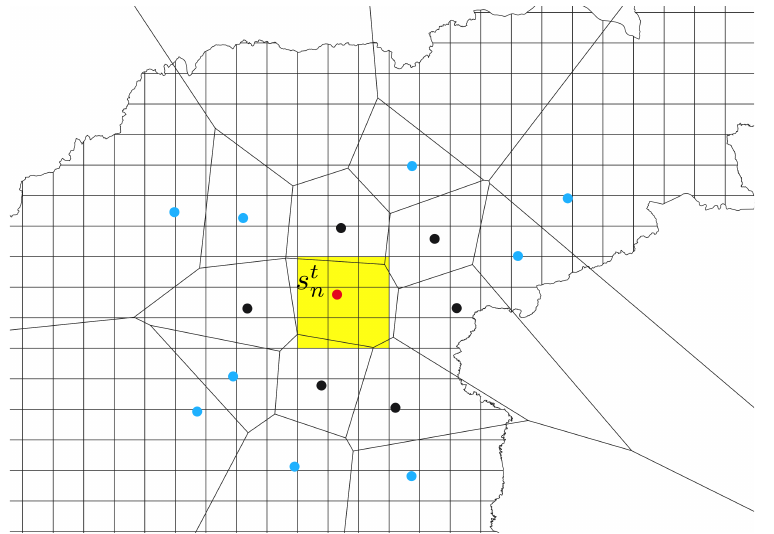
Figure 2. Voronoi diagram constructed on the sensors, where sensor s t n is marked by the red dot, its natural neighbors by the black dots, while the remaining sensors are blue. Pixels whose centers are located within the Voronoi cell defined by s t n , represent target pixels and are colored in yellow. The polyline symbolizes the border of the observed